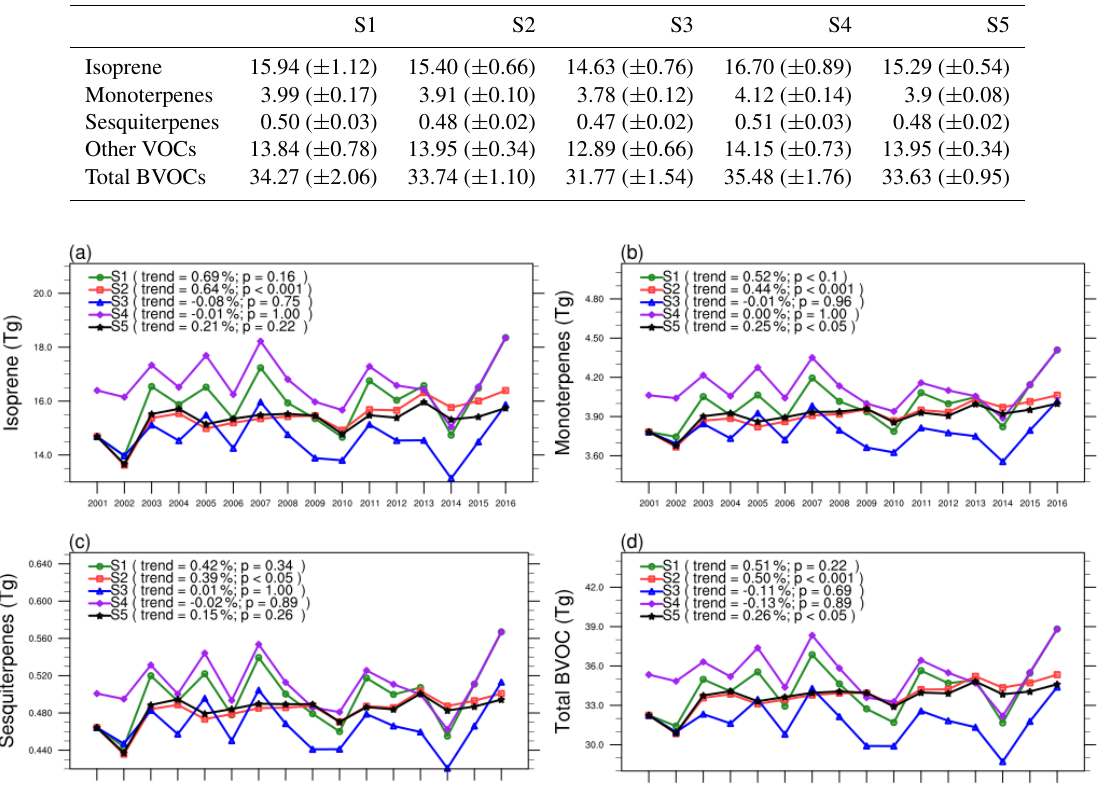
Table 2. The mean annual emission (Tg) of different species in China from 2001 to 2016. The scenarios S1 to S5 are described in Table 1.